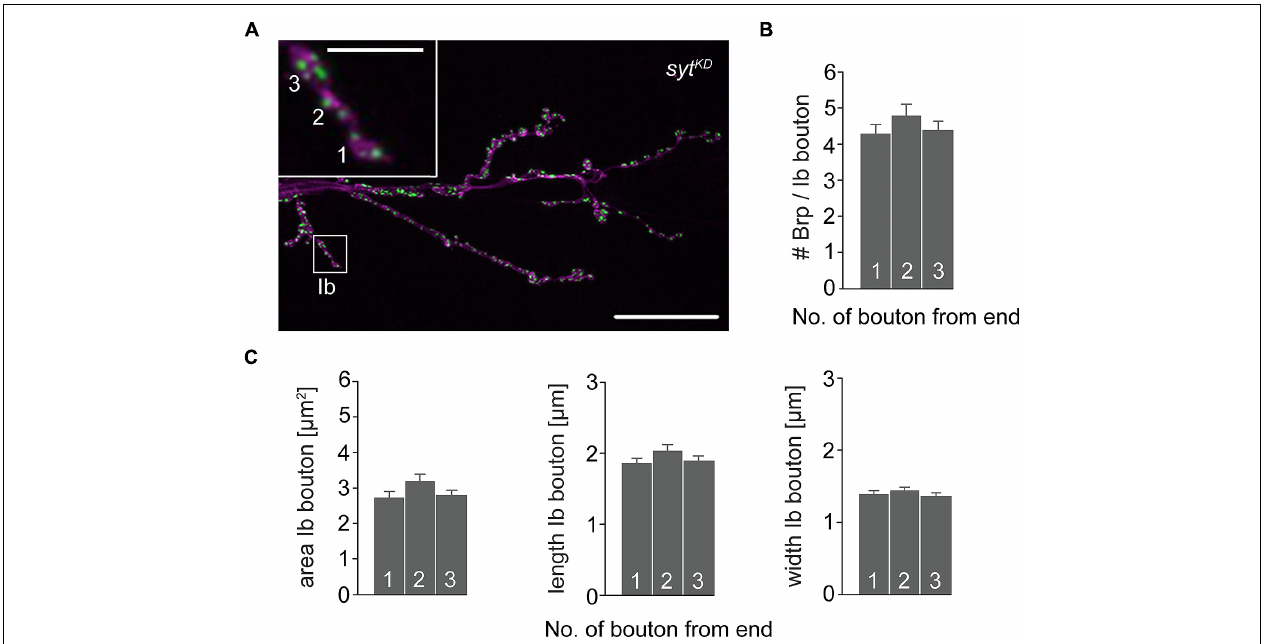
FIGURE 8 |Type Ib bouton morphometry in syt KD . (A) syt KD NMJ stained with α -HRP against neuronal membranes (magenta) and mAb Brp Nc 82 (green). Higher magnification of type Ib ending (white box) showing the three